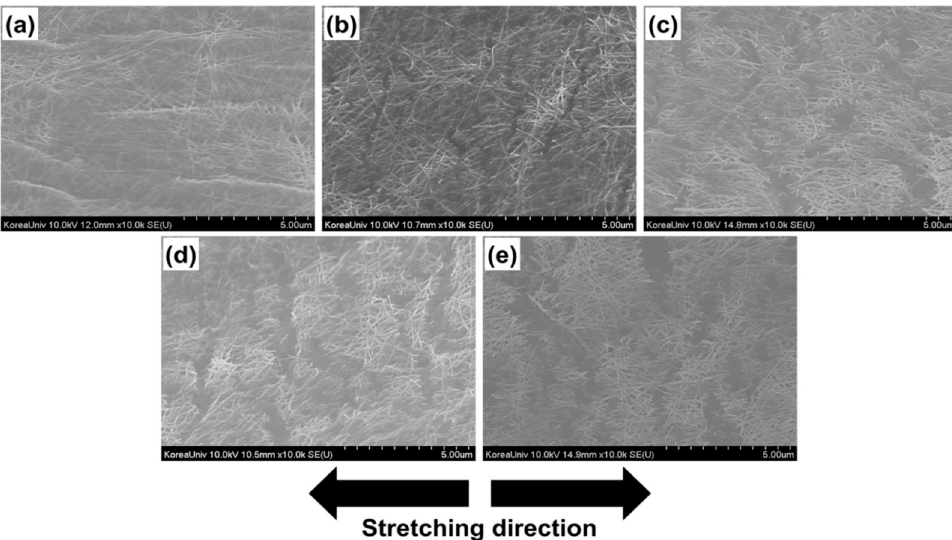
Figure 4. SEM images of AgNW/PDMS ( a ) in the relaxed state and at a strain of ( b ) 25%, ( c ) 50%, ( d ) 75%, and ( e ) 100%. Adapted under the terms of the CC-BY 4.0 license from Ref. [67]. Copyright 2017, The Authors, published by Nature Portfolio.